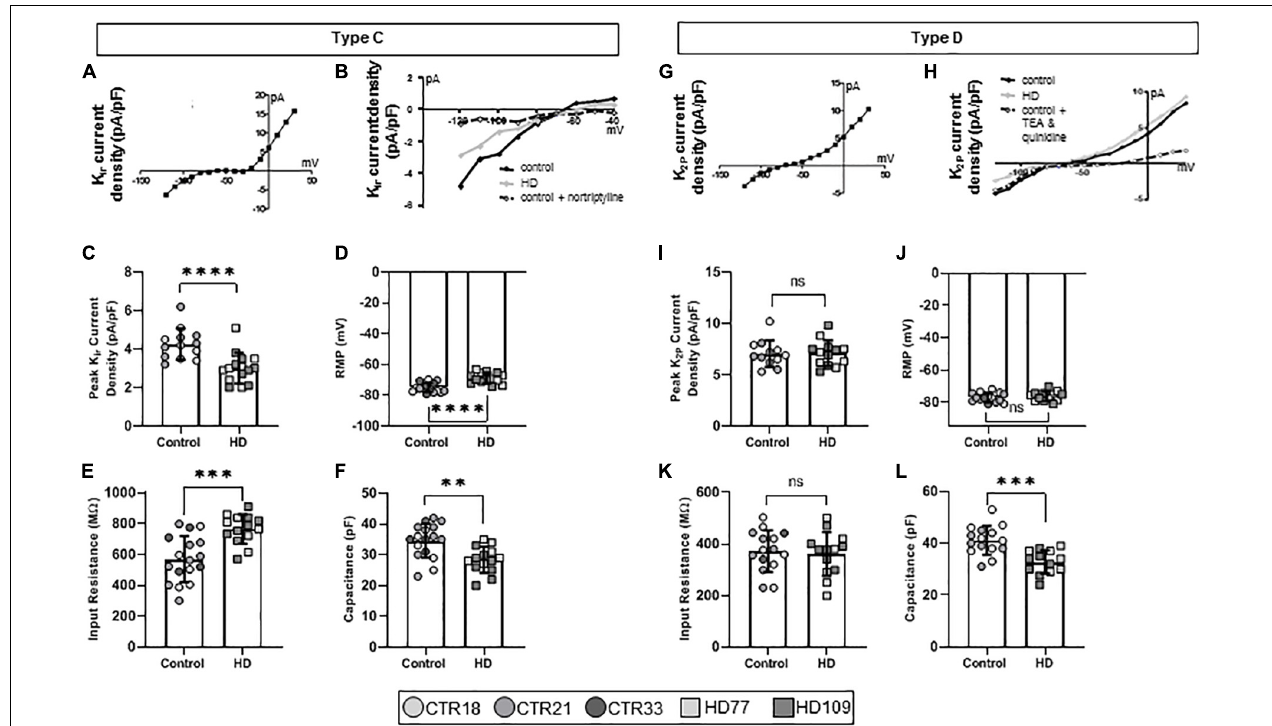
FIGURE 3 | Huntington’s disease iPSC-derived K ir channel-expressing (Type C) astrocytes display different current densities, resting membrane potential, input resistance and capacitance. (A) Type C astrocytes express K ir currents in Stages 3 and 4 cultures. (B) Example IV curve from Type C HD, control and control + nortriptyline astrocytes. (C) Type C HD astrocytes display significantly less peak K ir current density as compared to controls. (D) Type C HD astrocytes have depolarized resting membrane potentials and (E) an increased input resistance compared to controls. (F) Type C HD astrocytes have decreased capacitance compared to controls. (G) Mature Type D astrocytes express K 2 P currents in Stages 3 and 4 cultures. (H) Example IV curve of K + current density from Type D HD, control and control + TEA and quinidine astrocytes. (I) Peak K 2 P current density, (J) resting membrane potential, and (K) input resistance are similar between HD and control Type D astrocytes. (L) Type D astrocytes have smaller capacitances than control. Each cell is represented as a single point, and therefore N is represented on each graph. These cells all came from more than three separate experiments ( ∗∗ p < 0.01; ∗∗∗ p < 0.005; and ∗∗∗∗ p <